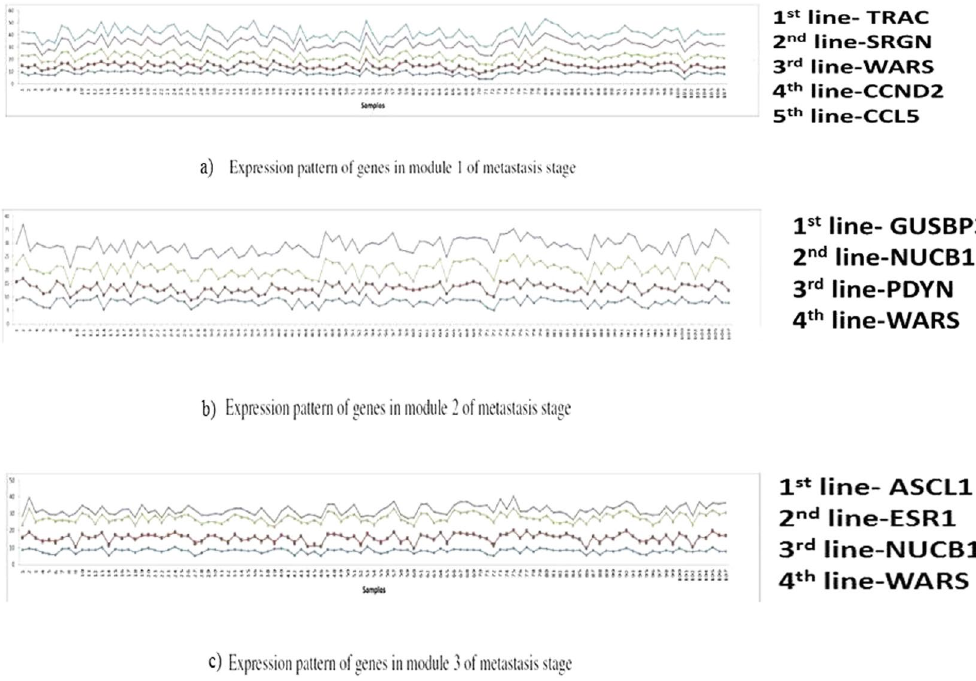
Figure 4. Expression patterns of genes in top three modules of metastasis